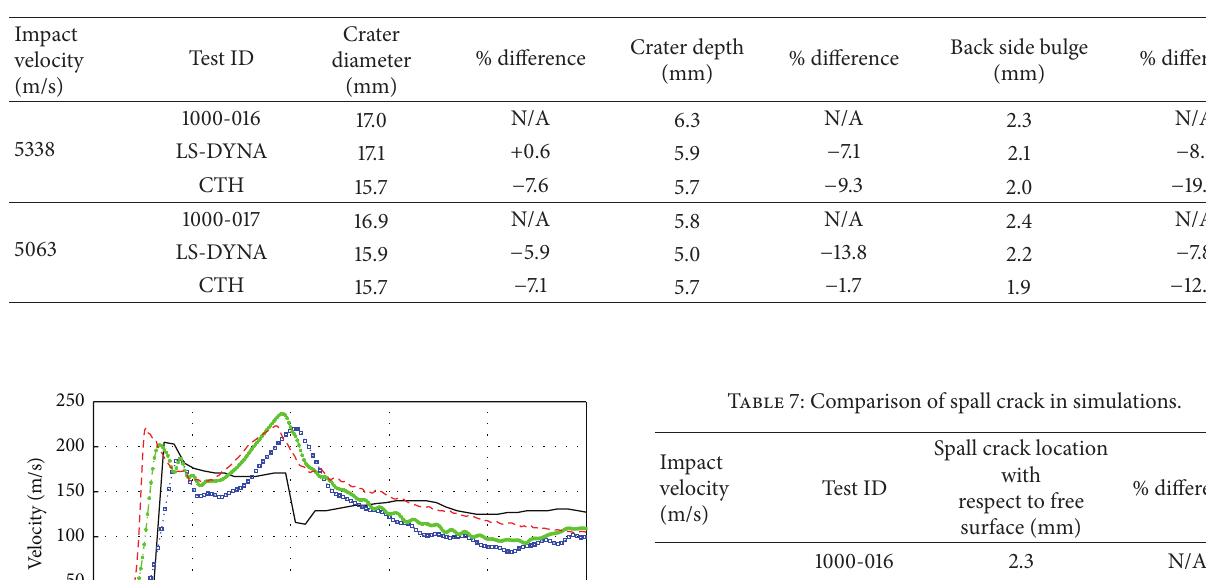
Table 6: Physical comparison of the impact craters.